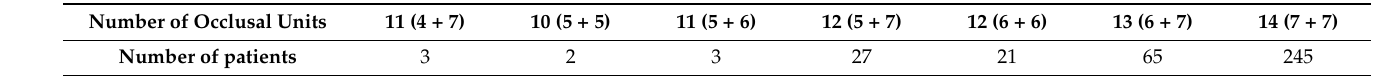
Table 5. Number of patients by number of occlusal units.